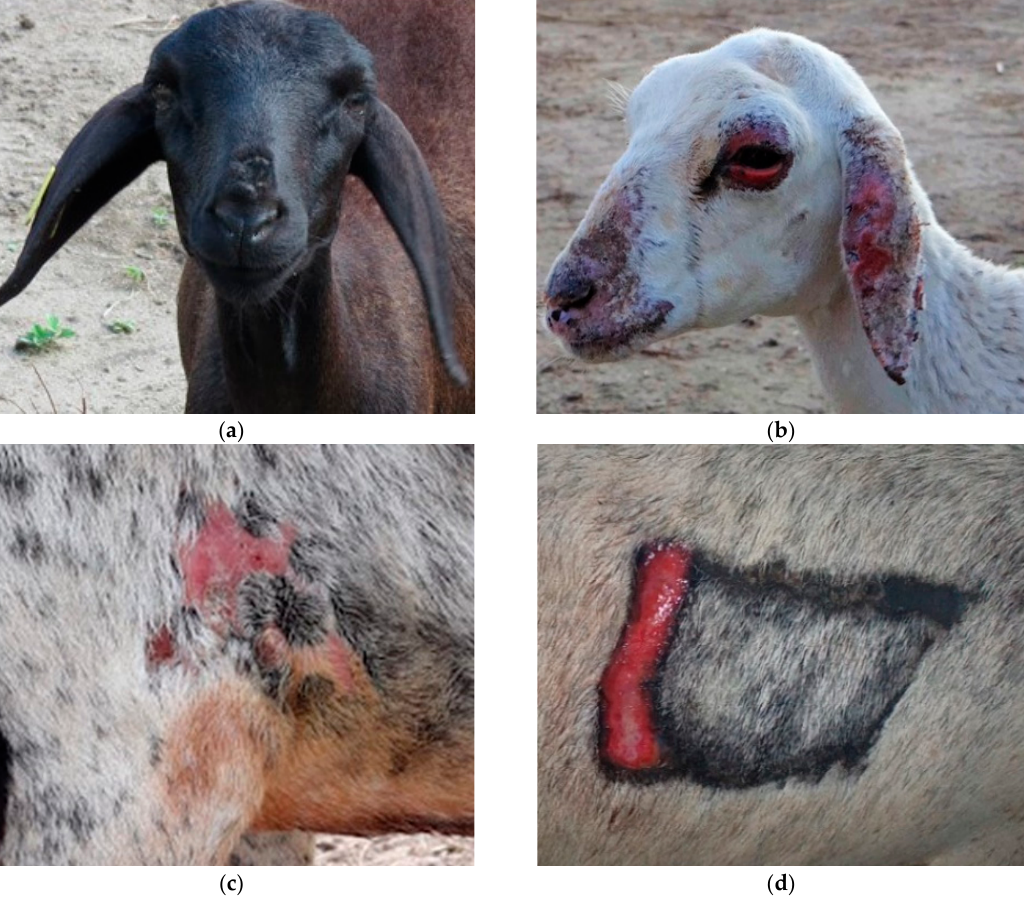
Figure 3. Experimental poisoning by Chamaecrista serpens in sheep. ( a ) Ov1 with slightly upturned ear tips, chamfer alopecia and edematous blepharitis. Day 23. ( b ) Ov2 on day 10, severe alopecic and crusted skin lesions on face, ears and mucucutaneous junction. ( c ) Ov3 on day 23, photosensitization lesions in depigmented areas of the axillary region. ( d ) Ov4 on day 23, photosensitization in the trichotomy region.